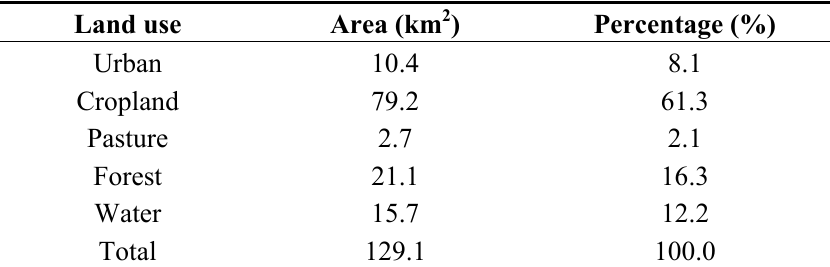
Table 4. Land use distribution for the study